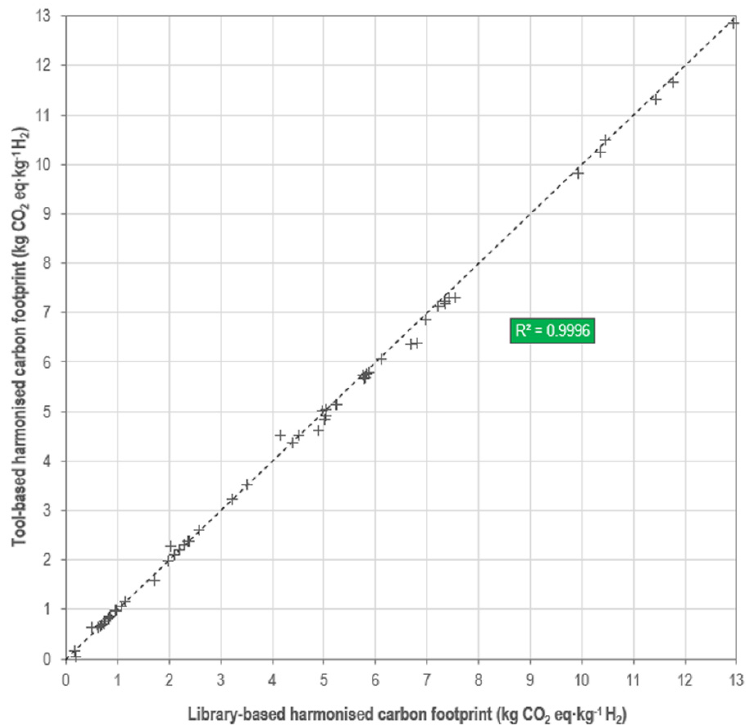
Figure 2. Linear regression between library- and tool-based harmonised carbon footprints.